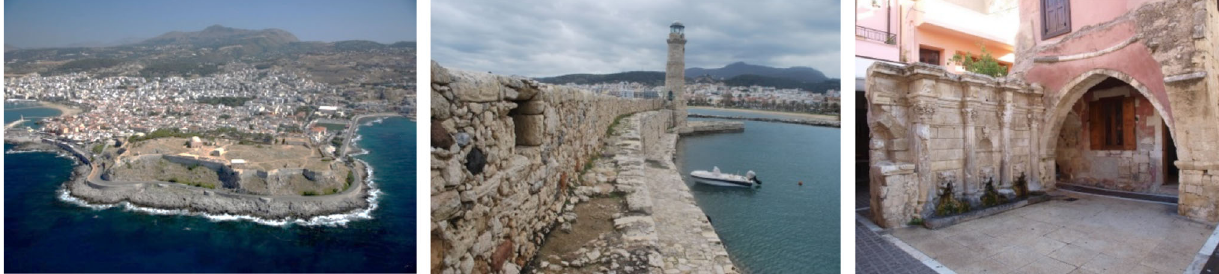
Fig. 4 Study sites in Rethymno, Crete, Greece. Left: Fortezza Fortress (cid:2) Patroudakis Georgios, 2010; Middle: Lighthouse in the Venetian harbor (cid:2) Ephorate of Antiquities of Rethymno archive, 2015; Right: Rimondi Fountain (cid:2) Ephorate of Antiquities of Rethymno archive,